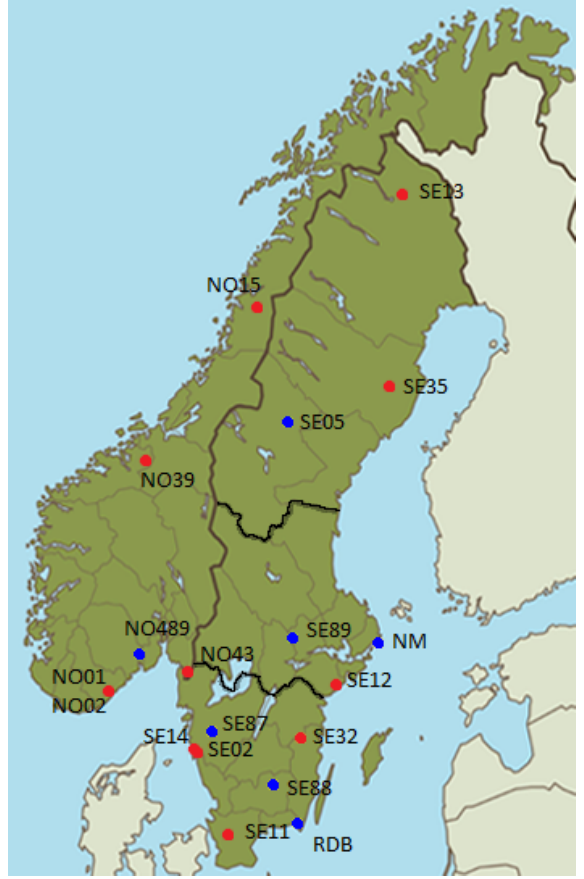
Figure 3. Instrumentation sites for hourly near-surface ozone con- centration observations in Sweden and Norway, which are used in the variational analysis. Red circles: sites with full data coverage. Blue circles: sites with restricted data coverage. The subdivision of Sweden into three regions (north, central and south) follows county borders, as indicated by the thick black